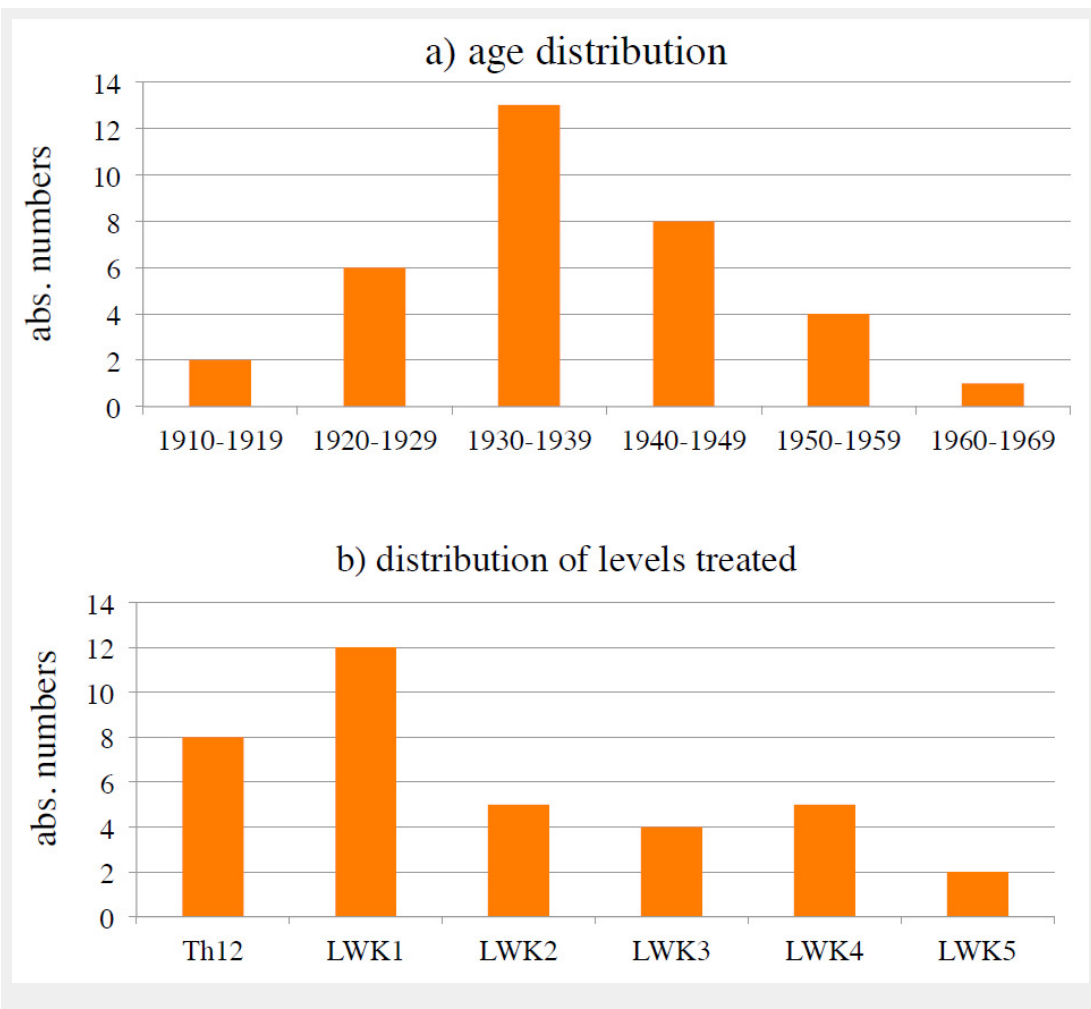
Stentoplasty patients (n = 34): a) age distribution of patients treated, b) distribution of levels